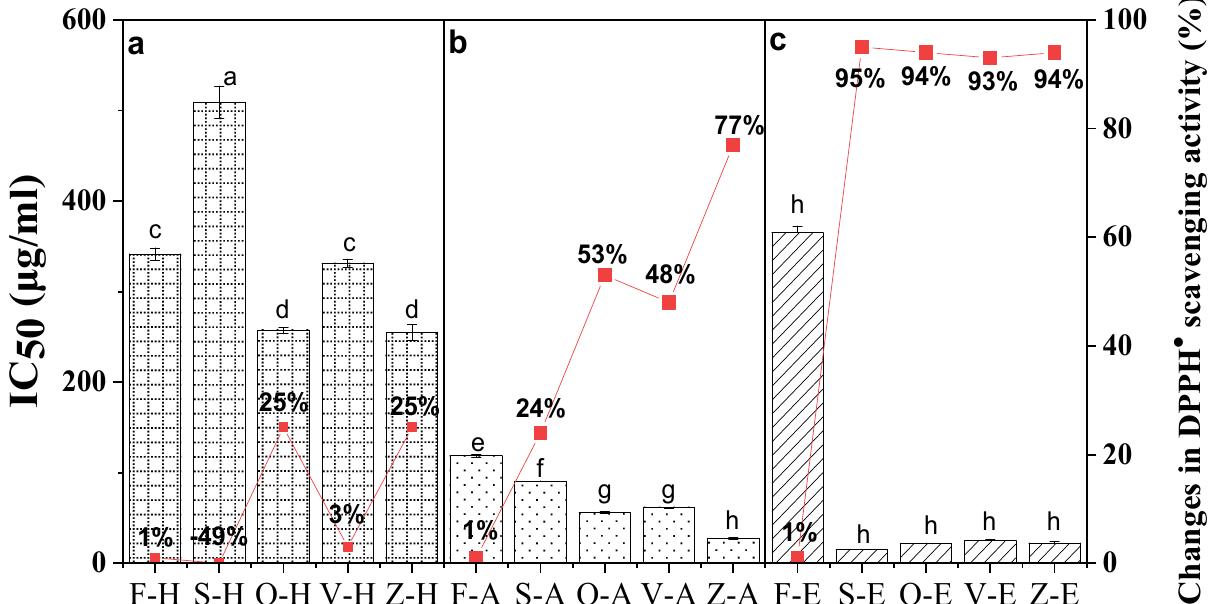
Figure 5. DPPH assay of Bentong ginger extracted using ( a ) hot water (H), ( b ) aqueous (A), and ( c ) ethanol (E) solvents via sun (S)-, oven (O)-, vacuum (V)- and freeze (Z)-drying methods. Fresh ginger (F) was used as the control. Changes were calculated based on the respective fresh ginger samples. Bars with different letters are significantly different. Sample F-H = Fresh ginger (Control) with hot water, and sample Z-E is freeze-drying with ethanol.